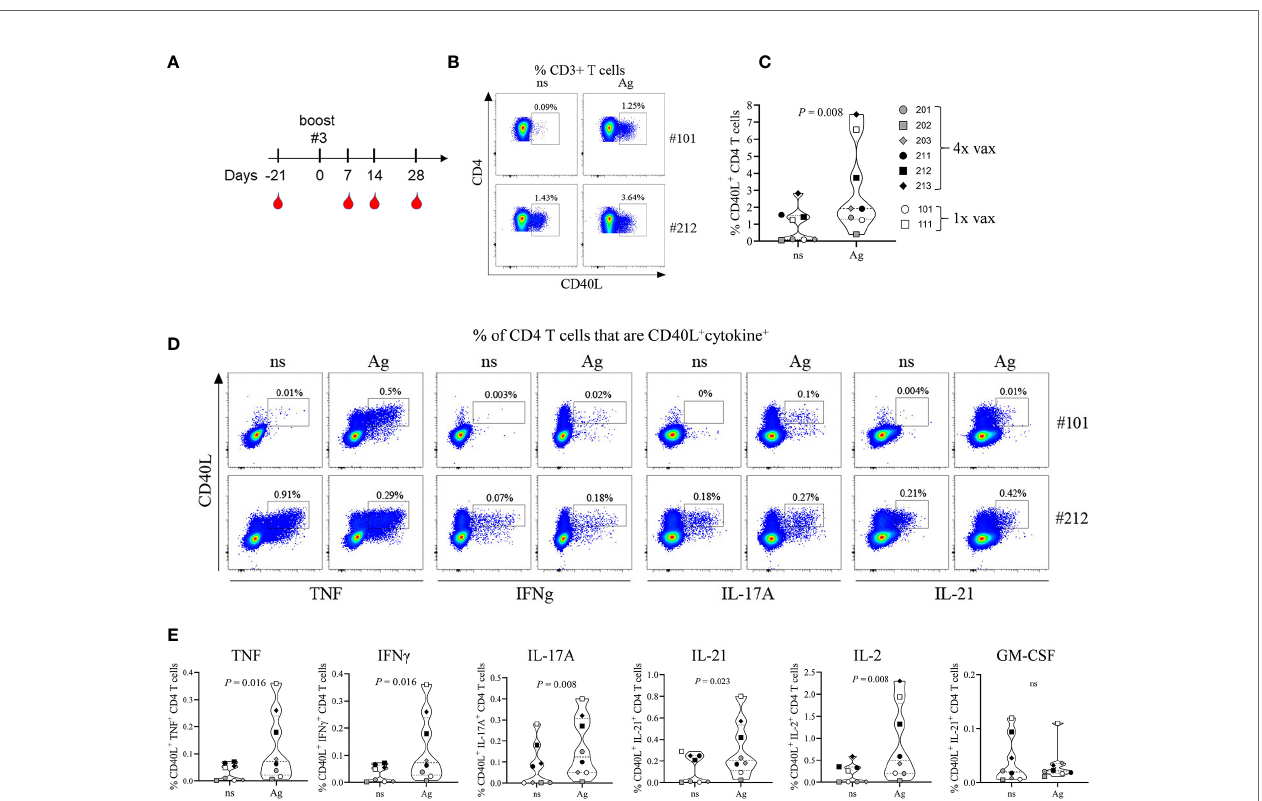
FIGURE 7 | Immunophenotyping of vaccine-generated CD4 T cells. Additional blood collection and vaccination schedule for non-human primates (NHPs) before and after boost #3 (A) . Frequency of total CD40L + CD4 T cells (B, C) or CD40L + cytokine + CD4 T cells (D, E) 14 days after primary vaccination (#101) or after boost #3 (#202). Representative plots (B, D) and summary data (C, E) . Non-stimulated (ns) and antigen stimulated (Ag) PBMCs. Data was analyzed with Flowjo v10.7 and GraphPad PRISM